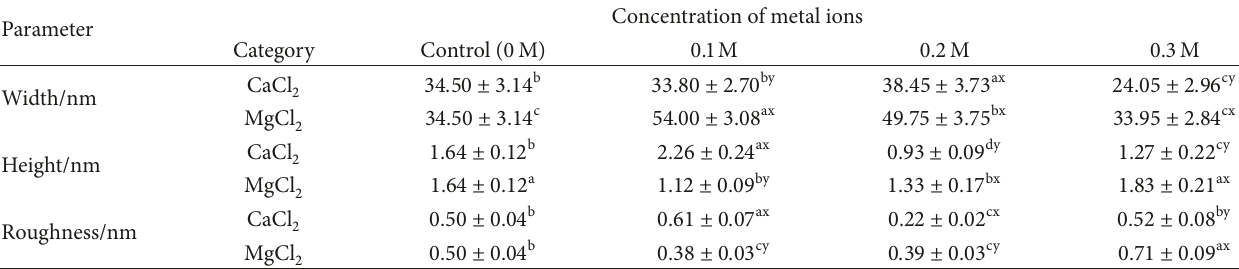
Table 3: Width, height, and roughness of the collagen self-assembly in different metal ions